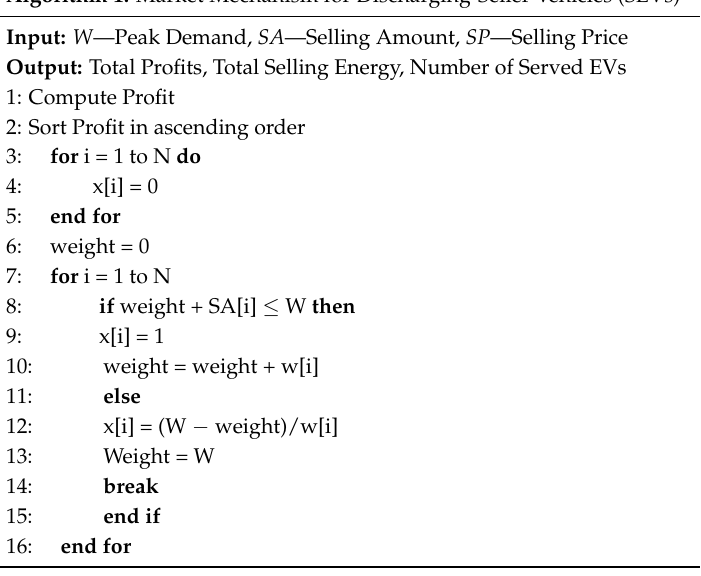
Figure 7. Results of the total COST for PLCC in Case (1): demand 50 kW, 10 EVs. Algorithm 1. Market Mechanism for Discharging-Seller Vehicles (SEVs)